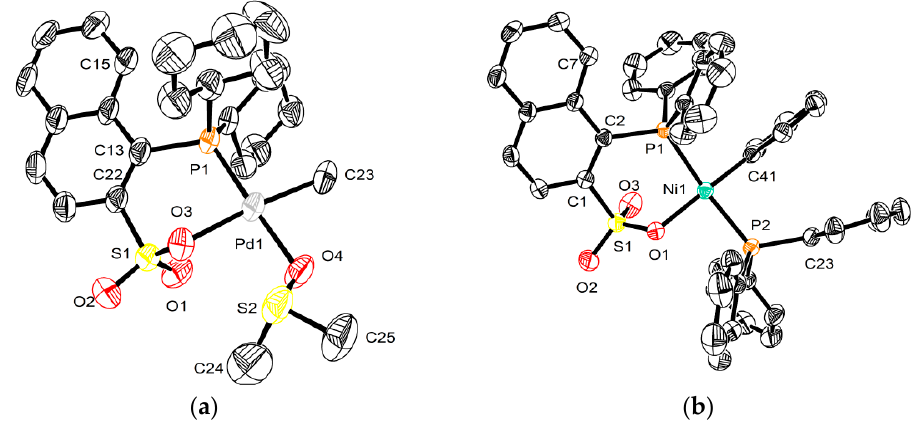
Figure 1. Molecular structures of: ( a ) Pd2 ; and ( b ) Ni1 . Hydrogen atoms have been omitted for clarity. Selected bond lengths (Å) and angles (°) for Pd2 : Pd1-C23 = 2.067(11), Pd1-P1 = 2.211(2), Pd1-O3 = 2.143(7), Pd1-O4 = 2.131(7), S1-O3 = 1.469(8), S1-O1 = 1.436(8), S1-C22 = 1.781(9), P1-C13 = 1.864(3), C13-C22 = 1.387(4), P1-Pd1-O32 = 91.3(1), P1-Pd1-O4 = 177.3(2), P1-Pd1-C23 = 94.7(3), Pd1-P1-C13 = 115.5(3), S1-O3-Pd1 = 112.9(4); for Ni1 : Ni1-C41 = 1.8873(15), Ni1-P1 = 2.2221(4), Ni1-P2 = 2.2100(4), Ni1-O1 = 1.9553(11), S1-O1 = 1.4352(13), P2-C23 = 1.8309(15), P2-C17 = 1.8118(17), P1-Ni1-O1 = 93.63(3), P1-Ni1-C41 = 88.18(5), P2-Ni1-O1 = 89.47(3), P2-Ni1-C41 = 89.62(5), O1-Ni1-C41 = 174.92(6).